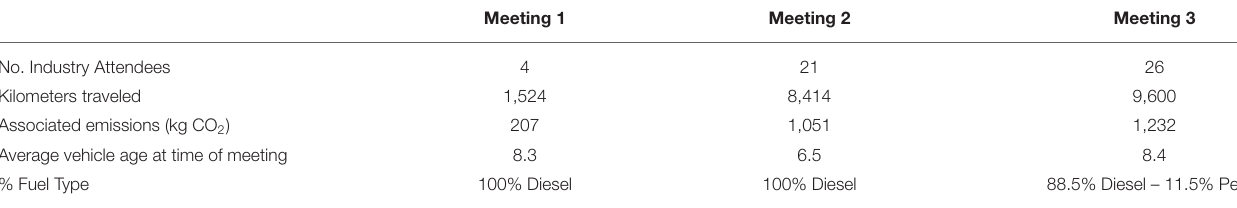
TABLE 4 | The number of attendees, and distance traveled increased for each progressive